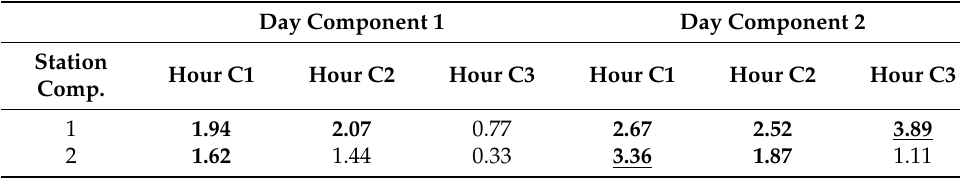
Table 5. Core array from Tucker3 analysis with P = 2, Q = 3, and R = 2 components for the dataset (with values exceeding 1.5 in absolute value being indicated in bold and values exceeding 3 in absolute value being underlined).